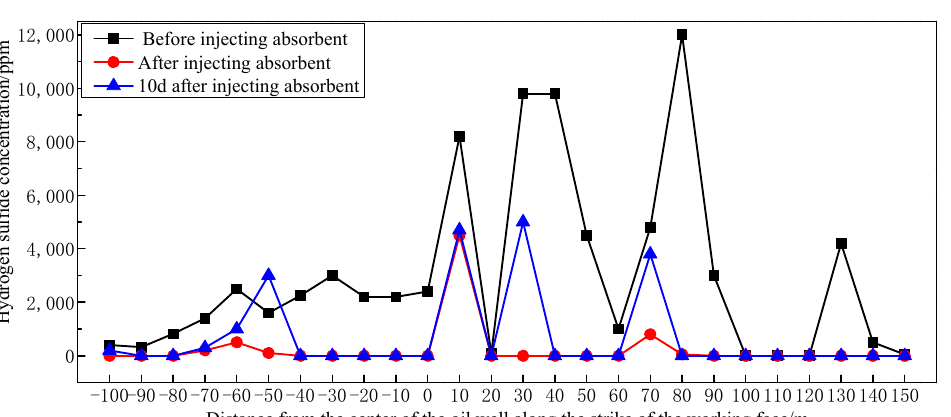
Figure 9. The trend diagram of hydrogen sulfide concentration before and after the absorbent injection in the abandoned oil well of Ma tan 31.